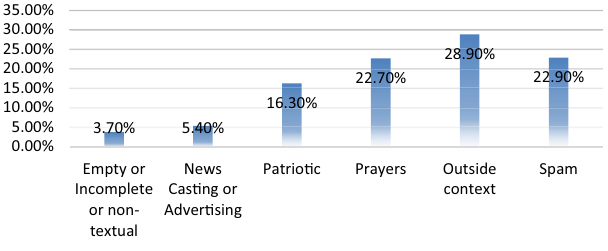
Figure 1. Irrelevant